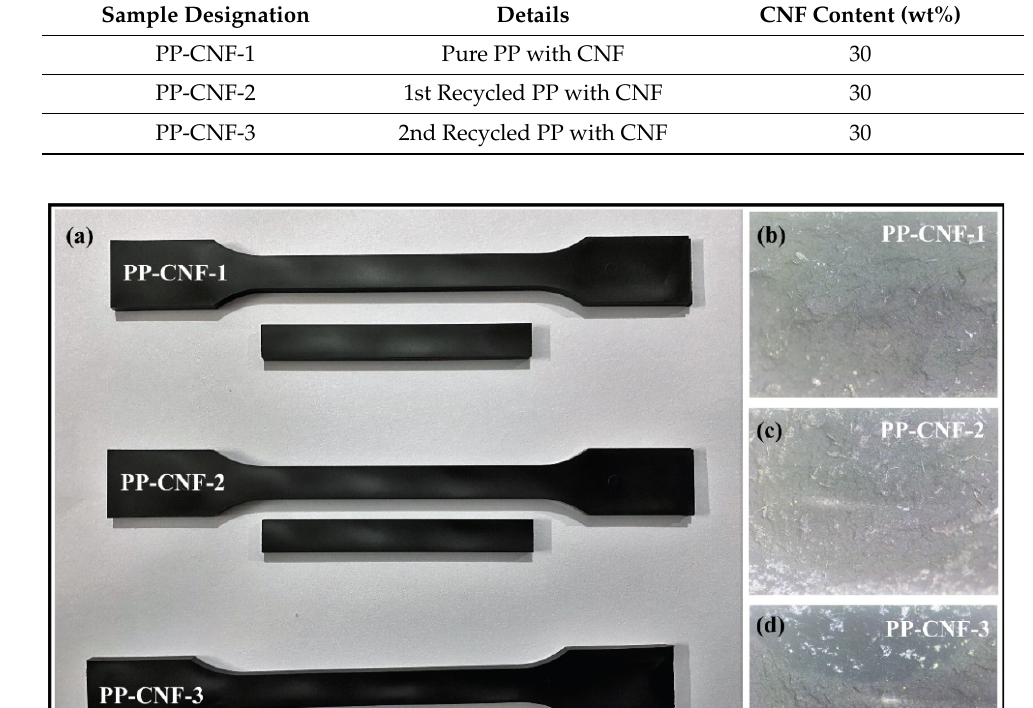
Table 1. List and description of the nanocomposite specimens.